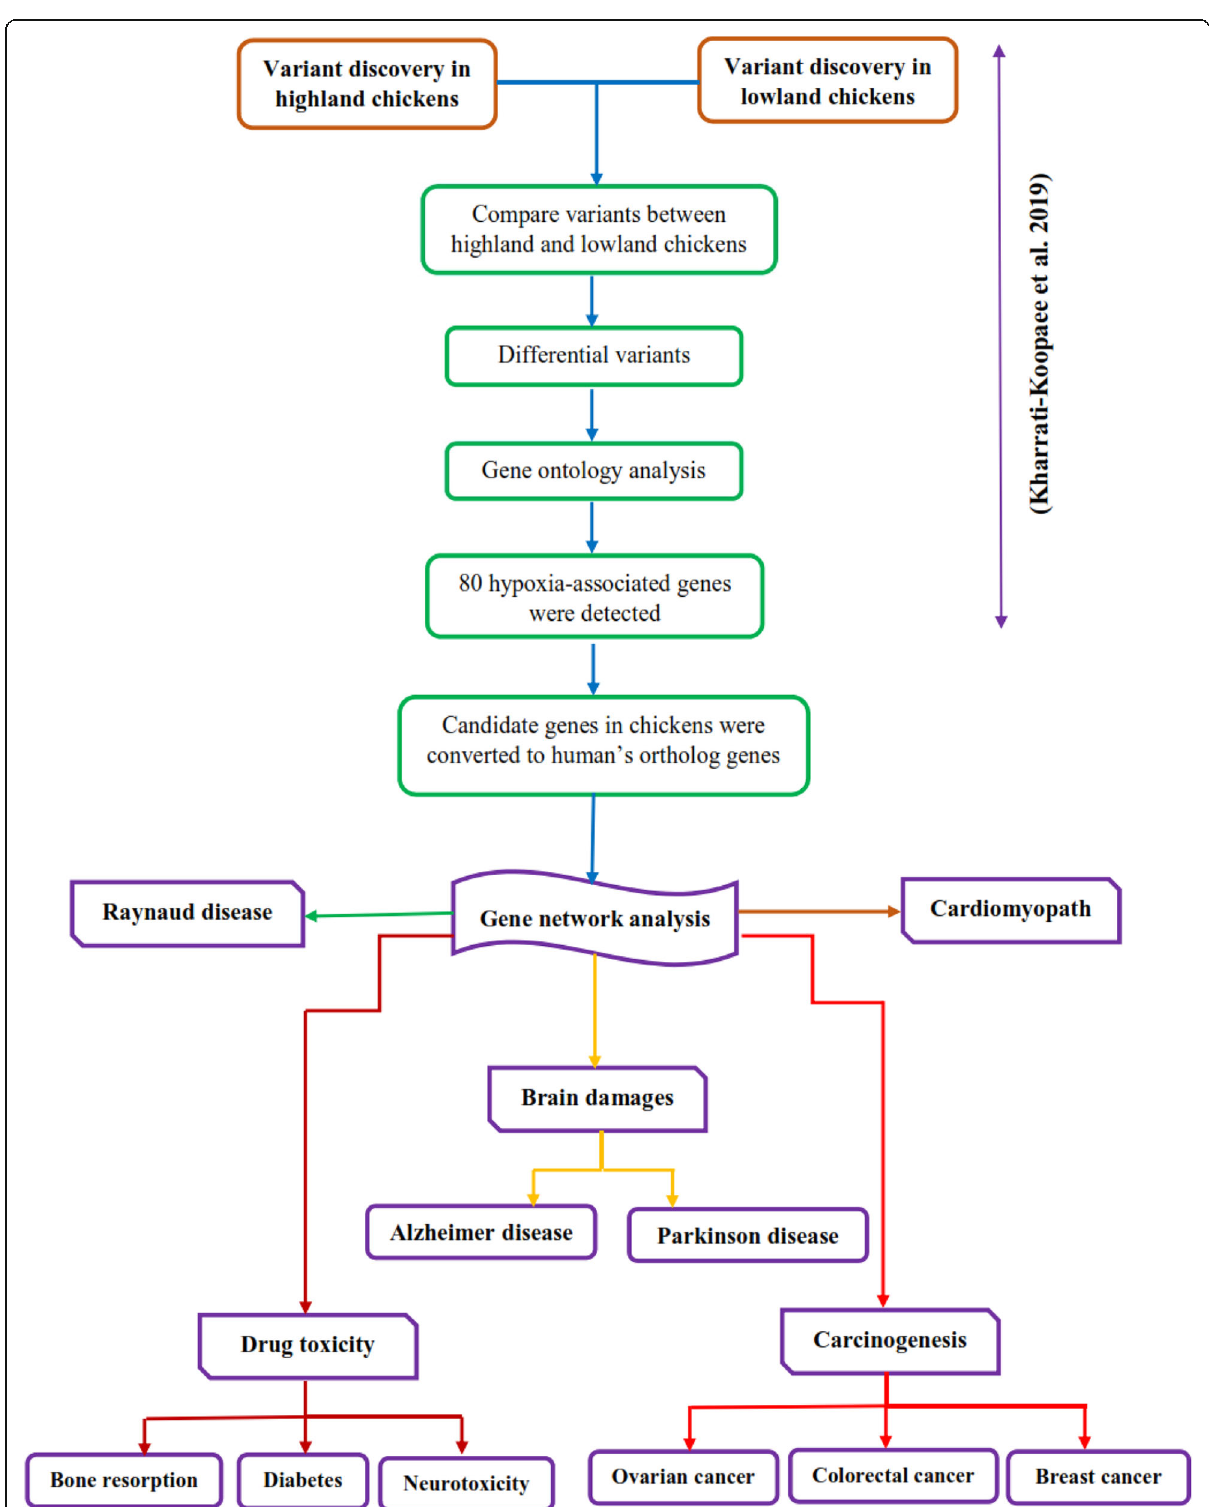
Fig. 1 The workflow of the variant detection and gene network analyses which are associated with human diseases such as brain damages, carcinogenesis, cardiomyopathy, and drug